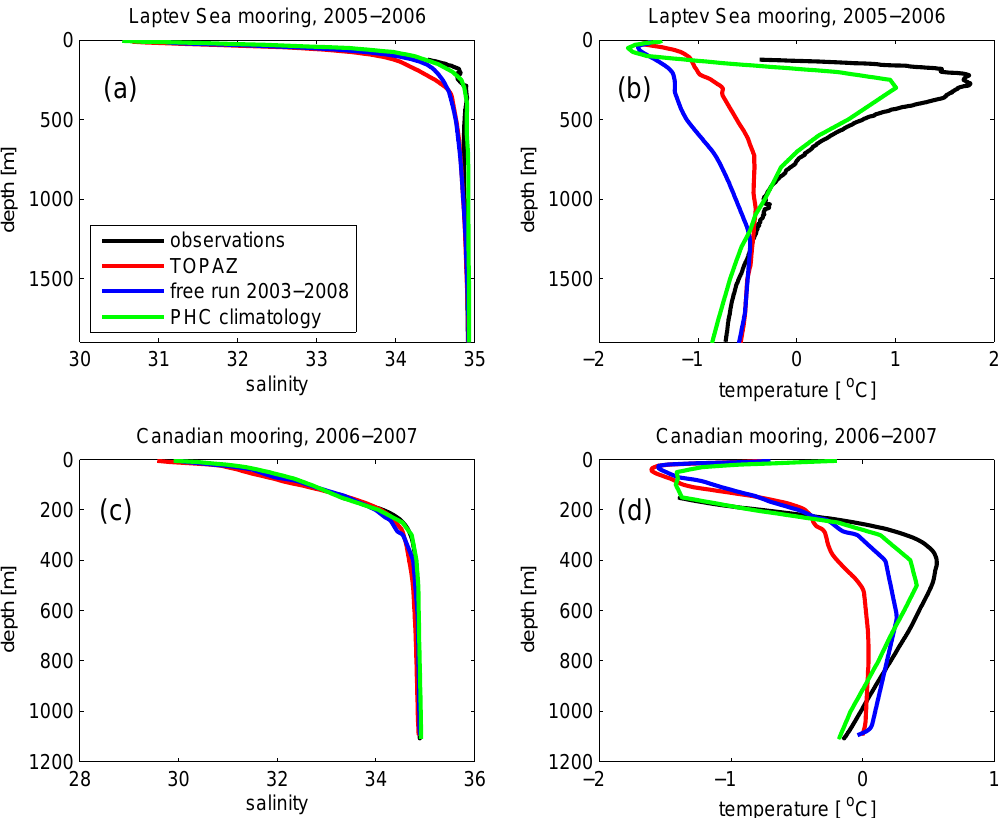
Fig. 16. Salinity (a, c) and temperature (b, d) profiles for the Canadian mooring C1F (71.50 ◦ N, 131.47 ◦ W) and Laptev Sea mooring M1C (78.43 ◦ N, 125.61 ◦ E), compared with PHC climatology, free model run and reanalysis; all data is averaged over the observation period